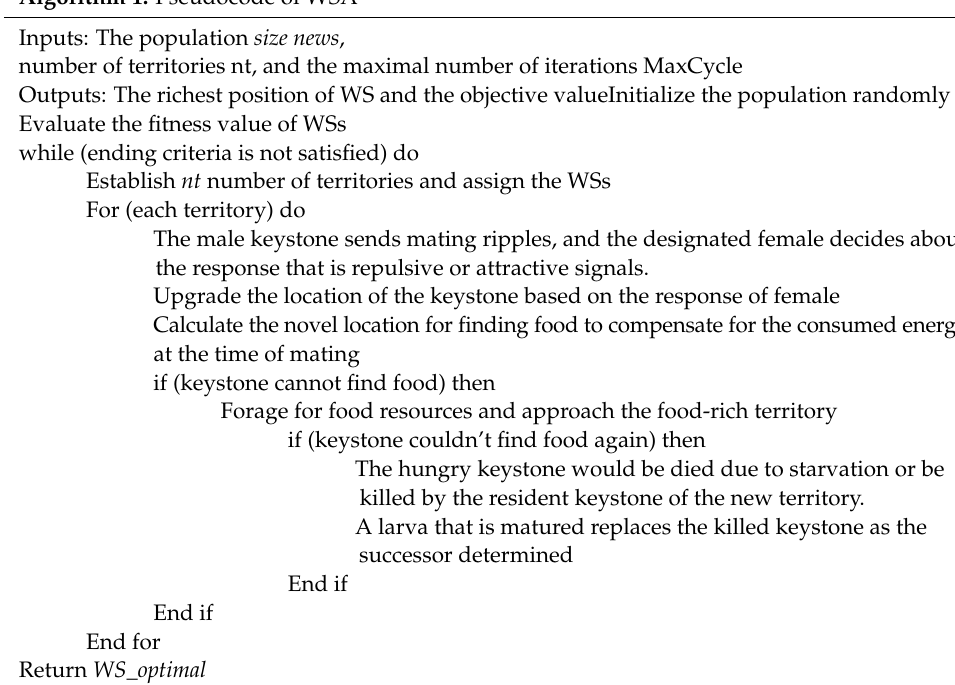
Algorithm 1: Pseudocode of